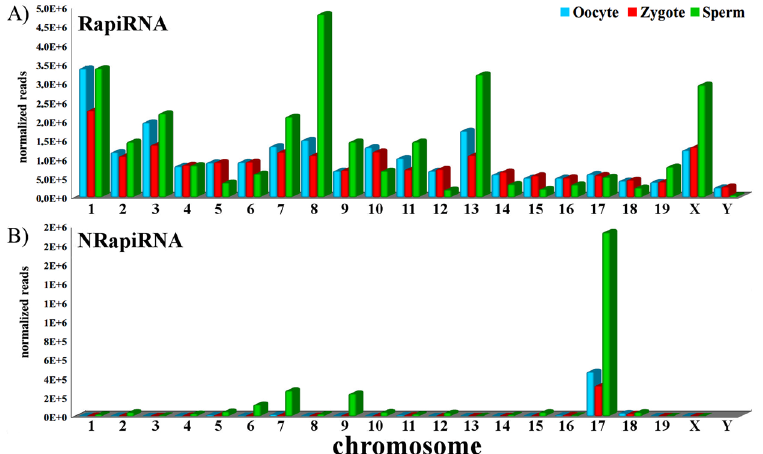
Figure 2. Mouse chromosome piRNA read distributions. Read counts of the three cell types were normalized using DESeq. RapiRNAs: Distribution of piRNA reads corresponding to sequences harbouring repeats and TEs. NRapiRNAs: Distribution of piRNA reads not associated with repeats nor TEs.